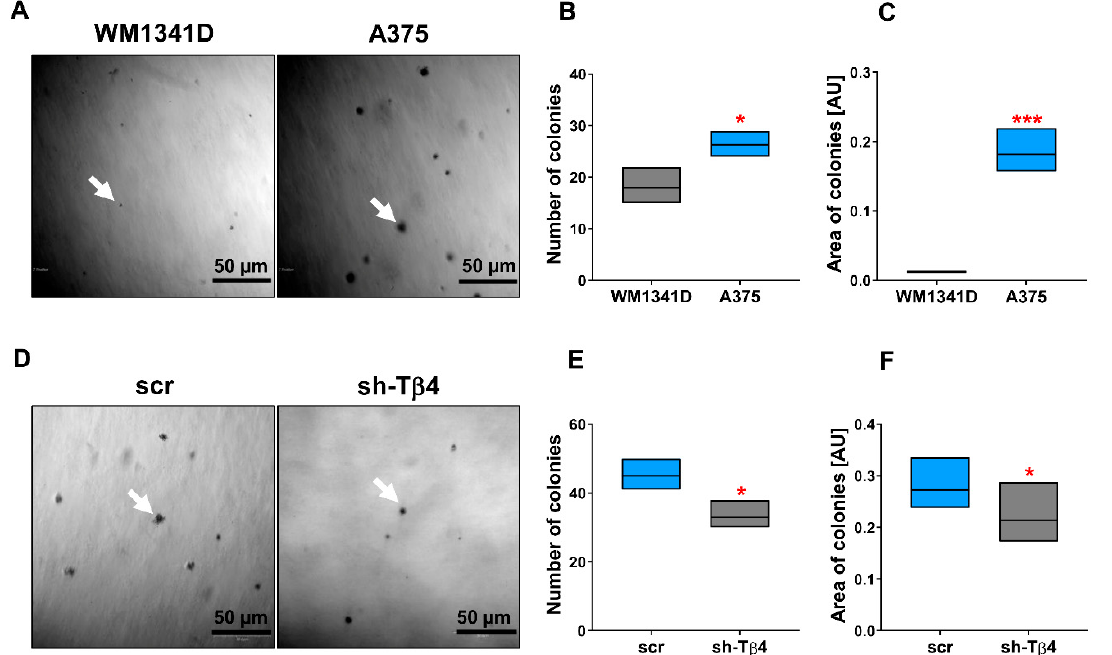
Figure 2. Characterization of WM1341D (low TMSB4X expression level) and A375 (high TMSB4X expression level) cells’ colony formation abilities in the soft agar colony formation assay and the effect of TMSB4X expression silencing on this parameter. ( A ) Representative phase-contrast images of colonies. White arrows indicate a single colony. ( B ) Quantitative analysis of the number of colonies ( n = 3^). ( C ) Analysis of colonies’ area ( n = 3^). ( D – F ) Analysis of colony formation ability of A375 control and sh-T β 4 cells. ( D ) Representative phase-contrast images of colonies formed by the A375 clones. White arrow point at a single colony. ( E ) Quantitative analysis of colonies (n = 3^). ( F ) Analysis of colonies’ area ( n = 3^). Measurements were performed with ImageJ software, which expressed results in arbitrary units (AU). The significance level was set at * p < 0.05, *** p < 0.001. Graphs indicate average-max-min values. ˆThe number of colonies formed and their area was calculated based on 21 microscopic pictures for every condition obtained from three separate experiments. The results presented separately for every clone are shown in Supplementary Figure S1.